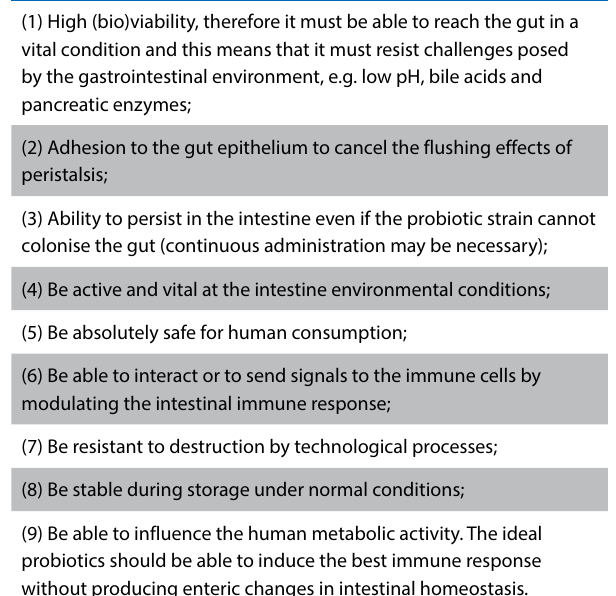
Table 1. Probiotic strain properties